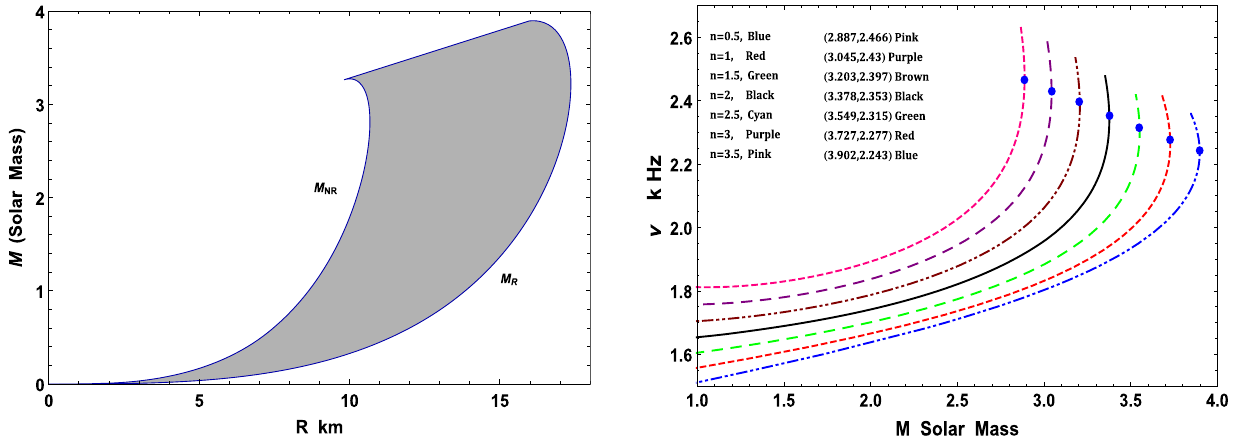
Fig. 9 M – R graphs for rotating (R) and non-rotating (NR) cases with a = 0 . 001 km − 2 and β = 0 . 2